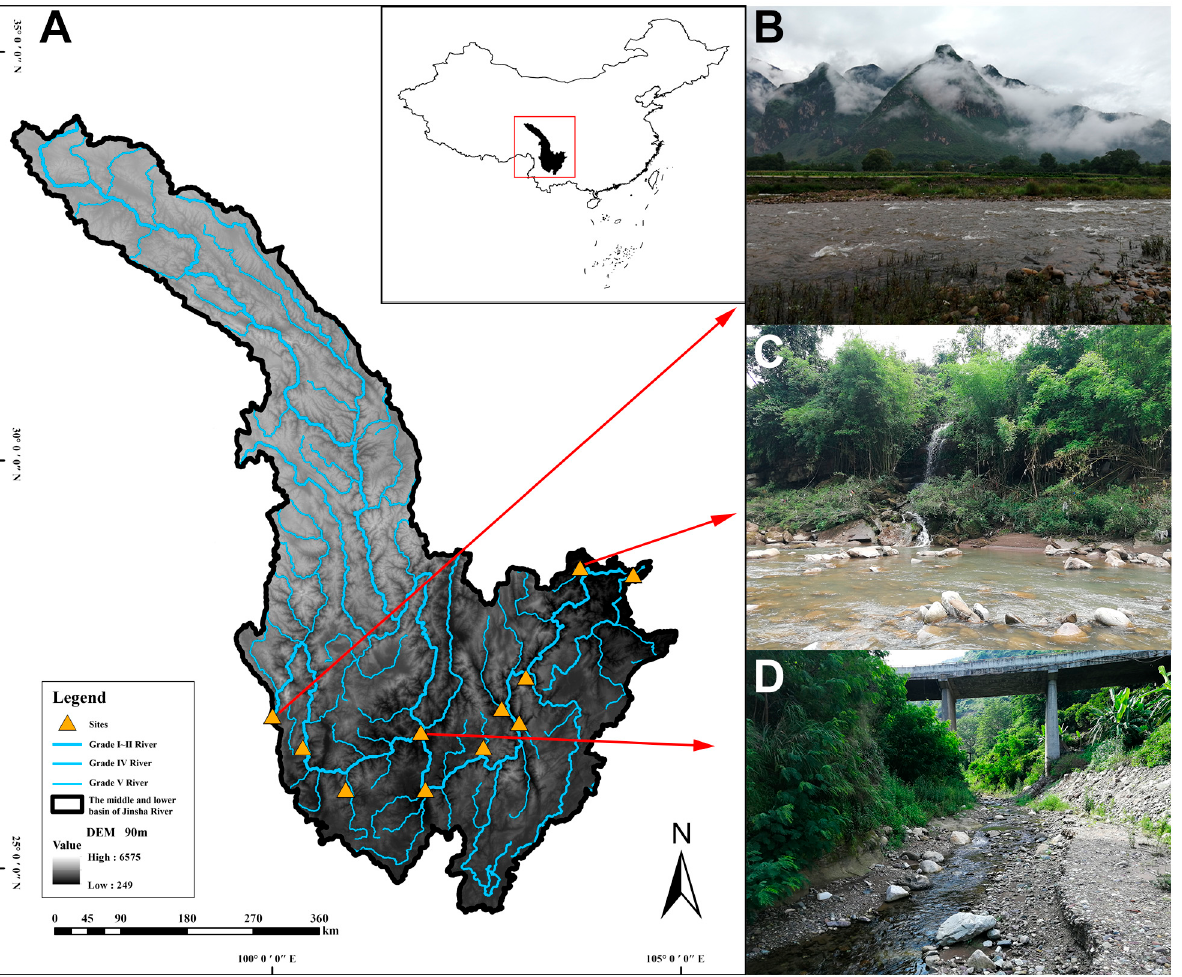
Figure 1. Map of the middle and lower reaches of the Jinsha River, showing collection sites. ( A ), hydrographic map of the middle and lower reaches of the Jinsha River with yellow triangles indicating the collection sites; ( B ), Chongsha River; ( C ), Xining River; ( D ), Yalong River.